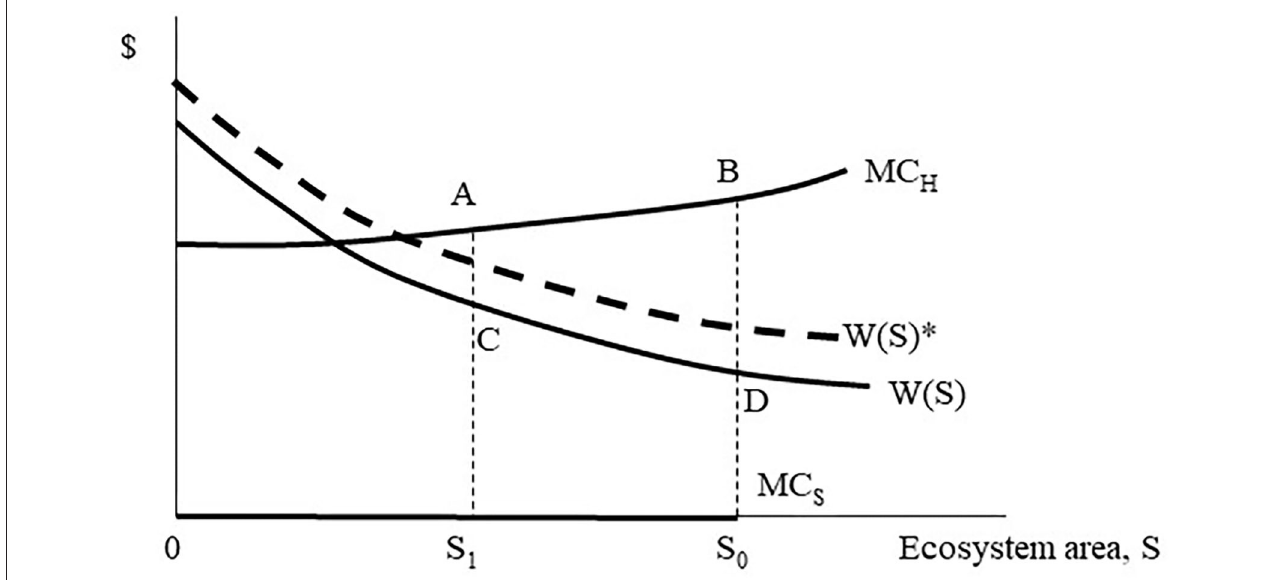
FIGURE 1 | The net benefits of the storm protection service provided by an estuarine and coastal ecosystem of area S 0 . The cost of the storm protection service provided by the ecosystem is “free” and is thus 0 S 0 . However, if the ecosystem area declines to S 1 , then there is a loss in net benefits from protection service represented by area S 0 CD S 1 . If the cost of replacing the loss in service by a human-built barrier is used to estimate the net benefits, this “replacement cost” estimate would be area S 0 AB S 1 . This method over-estimates the net benefits of the storm protection service by area ABCD. Note that, if the willingness to pay for protection service also includes not just protection of property and other assets from storms [curve W(S)] but also reducing the risk of injury, illness, or death and the disutility of risk exposure [curve W(S)*], the net benefits of storm protection service will be greater than area S 0 CD S 1 . However, as shown in the figure, the replacement cost method still over-estimates these net benefits. MCs, Marginal cost of the "free" protective service provided by the coastal wetland; MCH, Marginal cost of building a storm barrier "replace" the protective service provided by the coastal wetland; W(S), Demand, or marginal willingness to pay, for protection service provided by wetlands of area S; W(S)*, Demand, or marginal willingness to pay, for protection service provided by ECE of area S, including reducing the risk of injury, illness or death and the disutility of risk